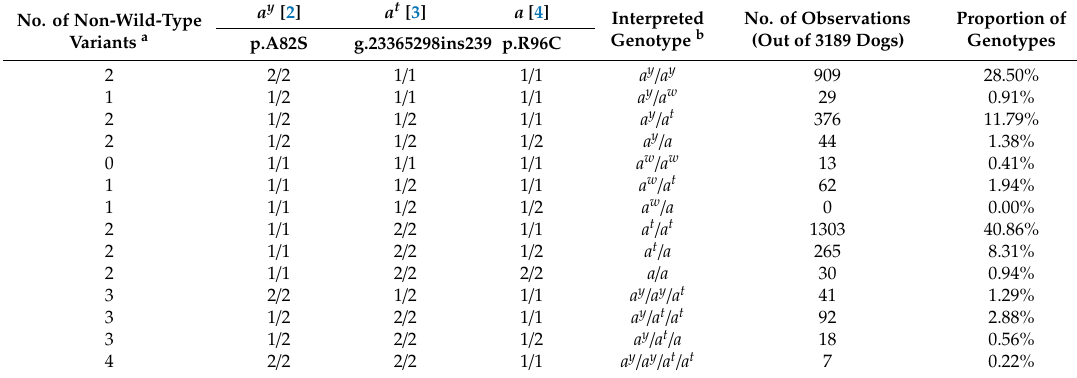
Table 2. Detected allele combinations in the Wisdom Health: Agouti Expansion (WHAE) cohort of 3189 dogs representing 17 breeds. The current dataset includes 158 dogs with A 3 + genotypes. Genotypes obtained for three ASIP mutations have traditionally been used to produce bi-allelic genotypes with a four allele hierarchy. Raw genotypes for a y , a t , and a are encoded as 1 = reference, 2 =